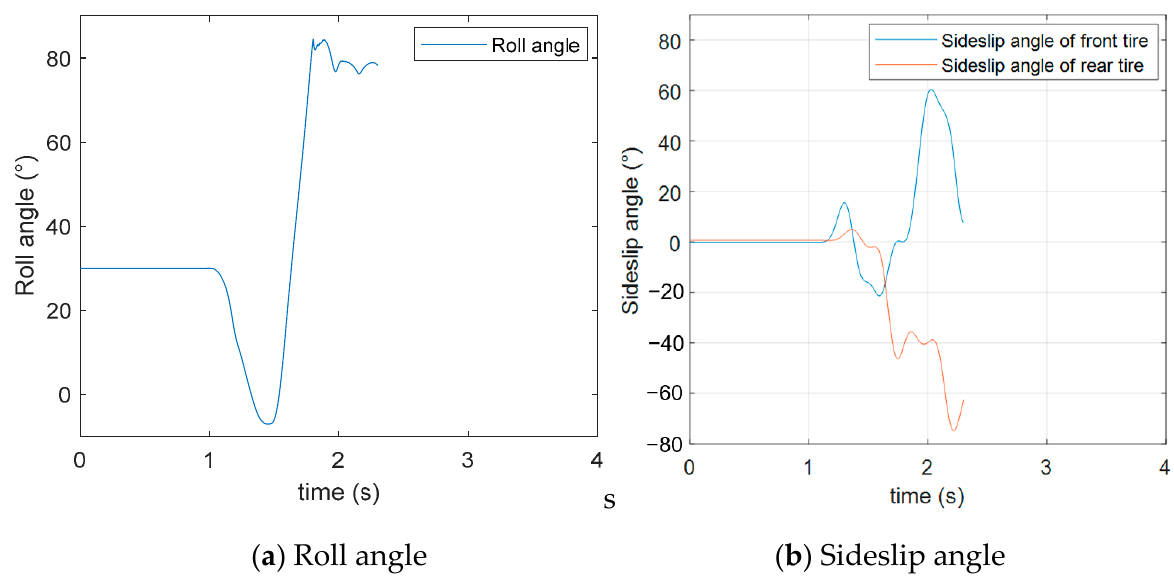
Figure 14. Braking performance for a fixed slip ratio input.